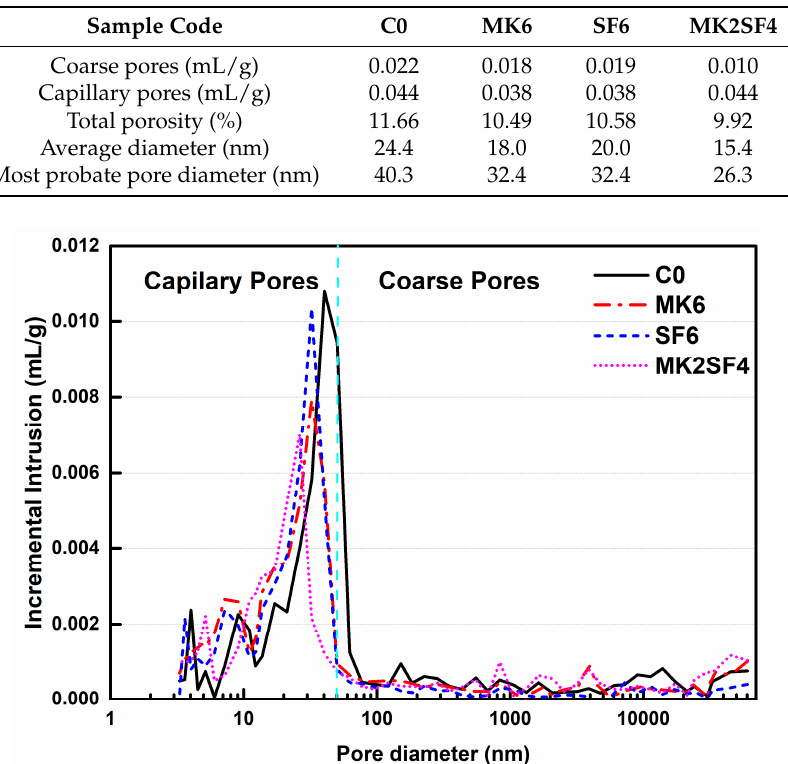
Table 5. Pore structure of SCC after curing for 28 days. Table 5 . Pore structure of SCC after curing for 28 days.